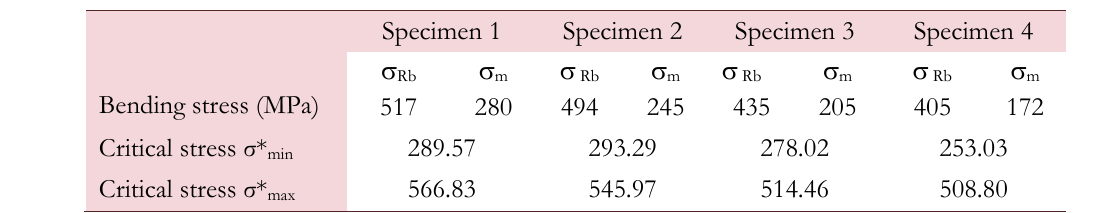
Table 1: Critical stress in a smooth cylindrical